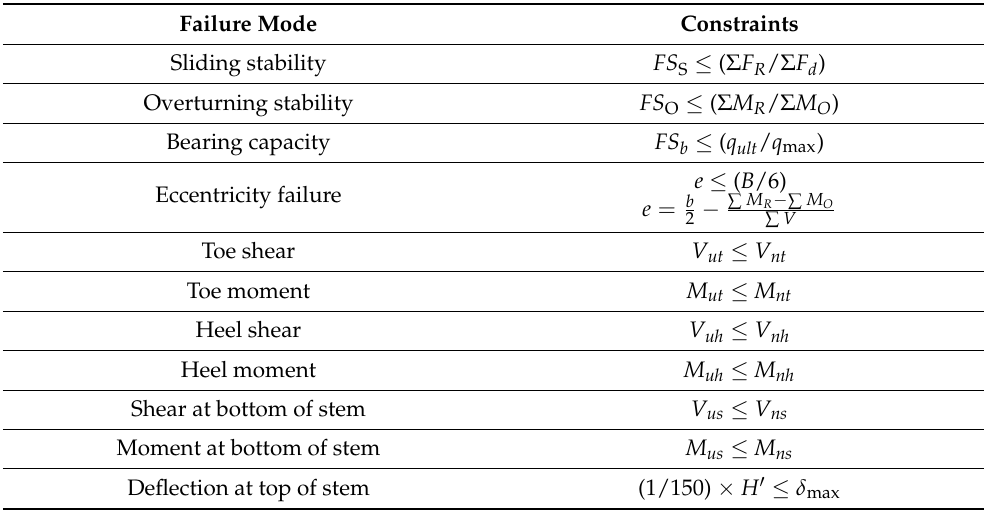
Table 11. Failure modes of retaining wall.